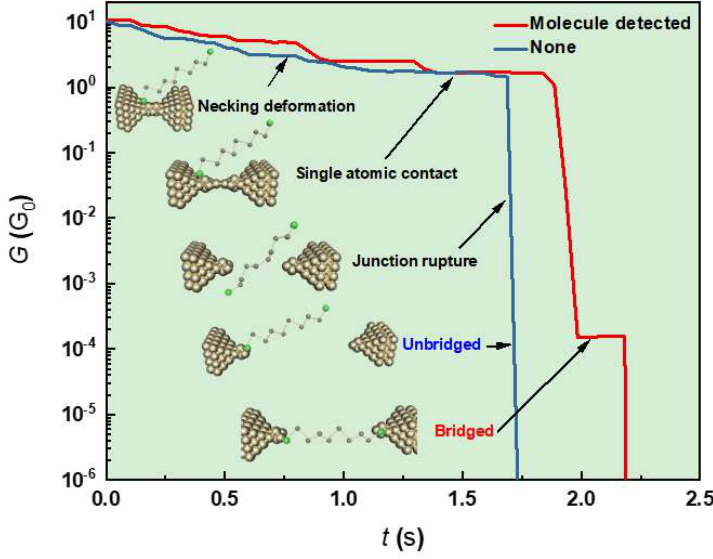
Figure 2. Conductance versus time trace during junction stretching with (red) and without (blue) a 1,8-octanedithiol molecule bridged between the Au electrodes. Inset images explain the contact mechanics involved in the measurement.